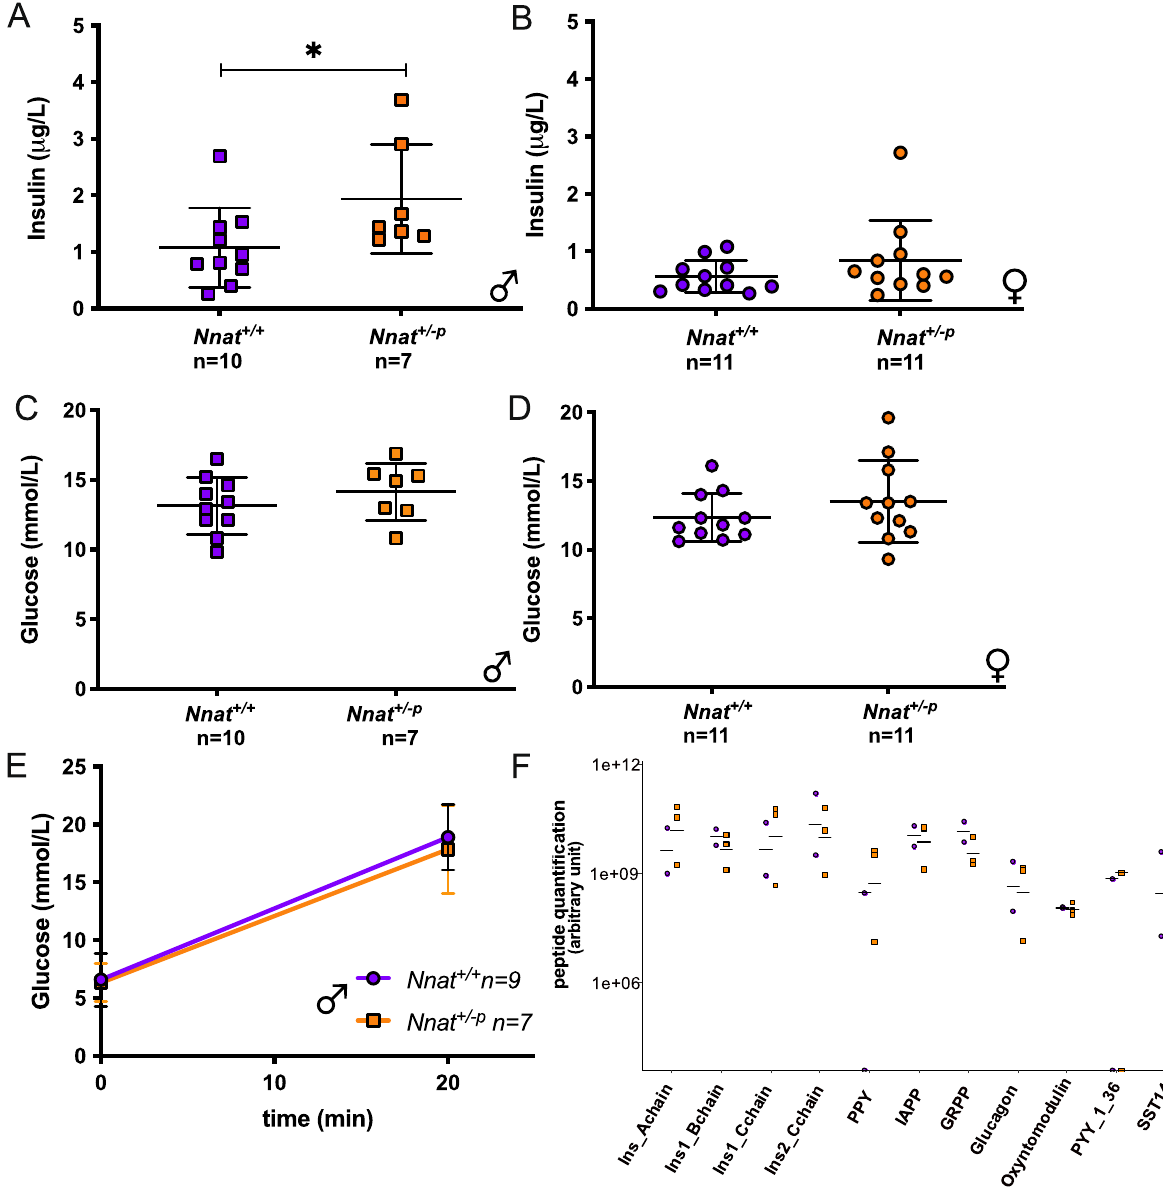
Figure 5. Glucose handling in Nnat deficiency. Ad libitum insulin and glucose levels in male ( A , C ) and female ( B , D ) mice fed on standard chow diet. Glucose measurements in overnight fasted Nnat + / + and Nnat + /−p male mice at time 0 and 20 min after glucose i.p. injection ( E ). Data are expressed as mean ± SD, * P < 0.05 for Mann– Whitney test. Mass spectrometry analysis of peptidome from Nnat + / + and Nnat + /−p pancreas in body weight- matched animals: ( F ) Pseudo-quantification of the main processed peptides produced in the pancreas; no major differences were detected in peptide levels. Data are expressed as mean (male; Nnat + / + (n = 2), Nnat + /−p (n = At thermoneutrality, in terms of the body weight of Nnat + /−p mice, both an increased variability and two clear mice considered “obese” was higher than that seen in chow. However, the small size of the cohort precluded more comprehensive analysis of the energy expenditure at 30 °C. going calorimetry studies, with a rate of weight gain in this calorimetry environment that was not representa- tive of that seen in the usual home cage. An increase in energy intake in Nnat + /−p mice was also seen in second, non-home cage system. The different effects of the novel environment on male and female mice have long been known 34 and studies on the role of Peg3 in maternal care and mother–pup interactions serve as an exemplar of how an imprinted gene can influence complex behaviour 35 . More recently, a fascinating complementary pattern of altered risk-taking behavioural phenotypes have emerged from studies of Nesp55 and Grb10 . They are both imprinted genes highly expressed at sites within the central nervous system, including the hypothalamus and